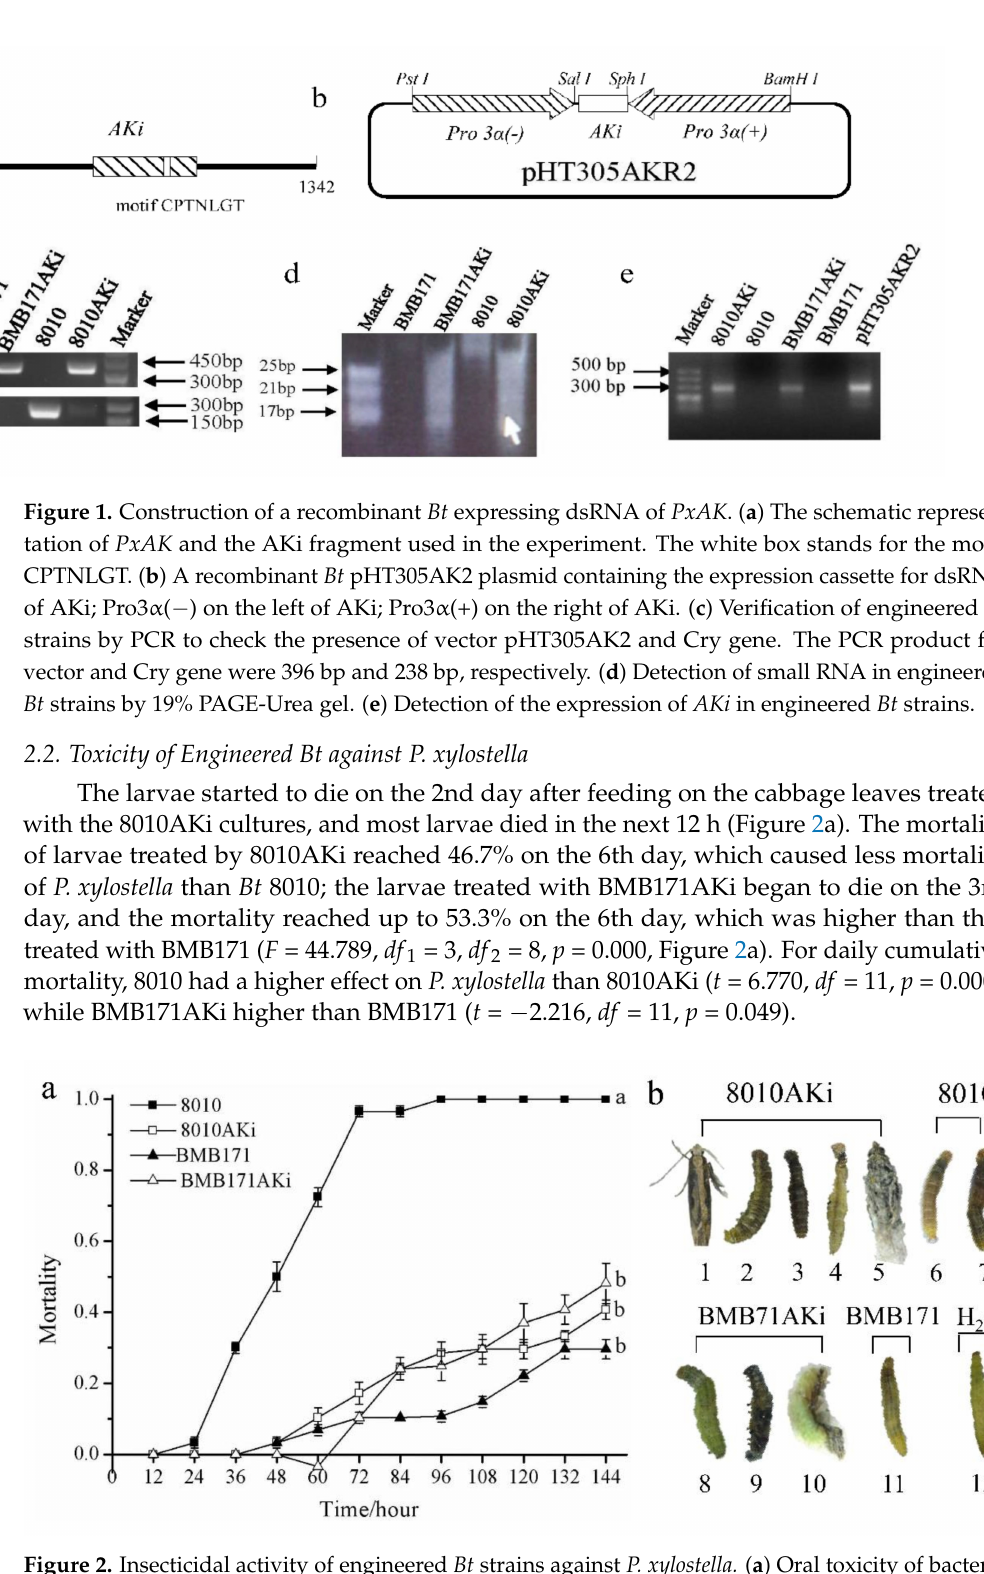
Figure 2. Insecticidal activity of engineered Bt strains against P. xylostella. ( a ) Oral toxicity of bacteria against P. xylostella . Each group contained 30 4th-instar larvae and mortality was measured every 12 h. ( b ) Effect of bacteria on P. xylostella development. In 1, the right antenna was shorter than the left; in 2, and 8, body appeared to exhibit shrinkage; in 3 and 9, the whole body turned blackish or green and the thorax appeared to exhibit shrinkage; in 4, thorax appeared to exhibit extreme shrinkage; in 5, the adult failed to break the cocoon; in 10, the pupa failed to ecdysis; in 6 and 7, the body turned black and erosive; in 11, the body was elongated; in 12, no abnormal phenotype was